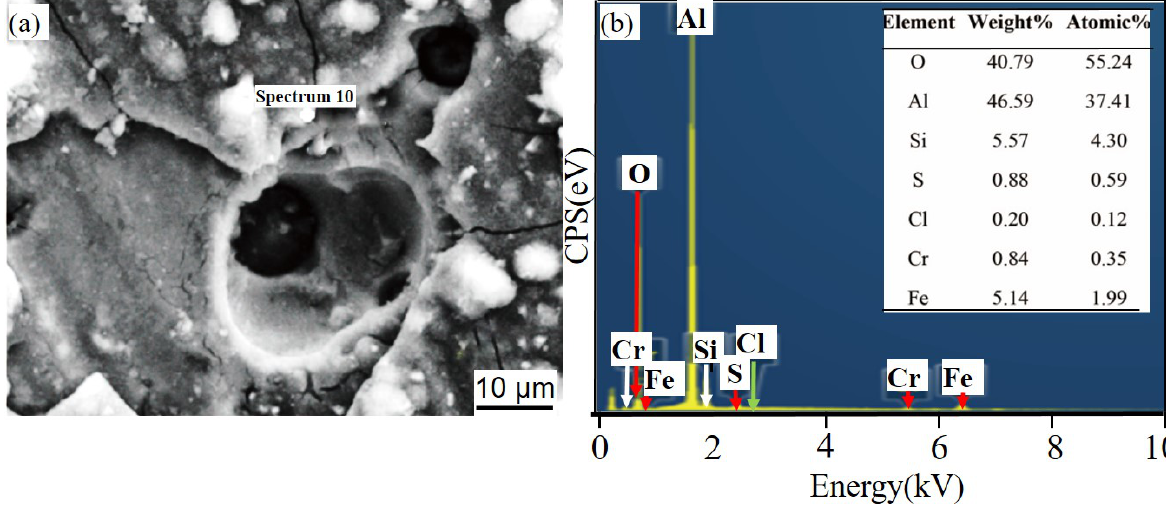
Figure 23. EDS of particle in 6061Al alloy corrosion pits after SL for 61 days. ( a ) SEM image of particle; ( b ) EDS of particle.